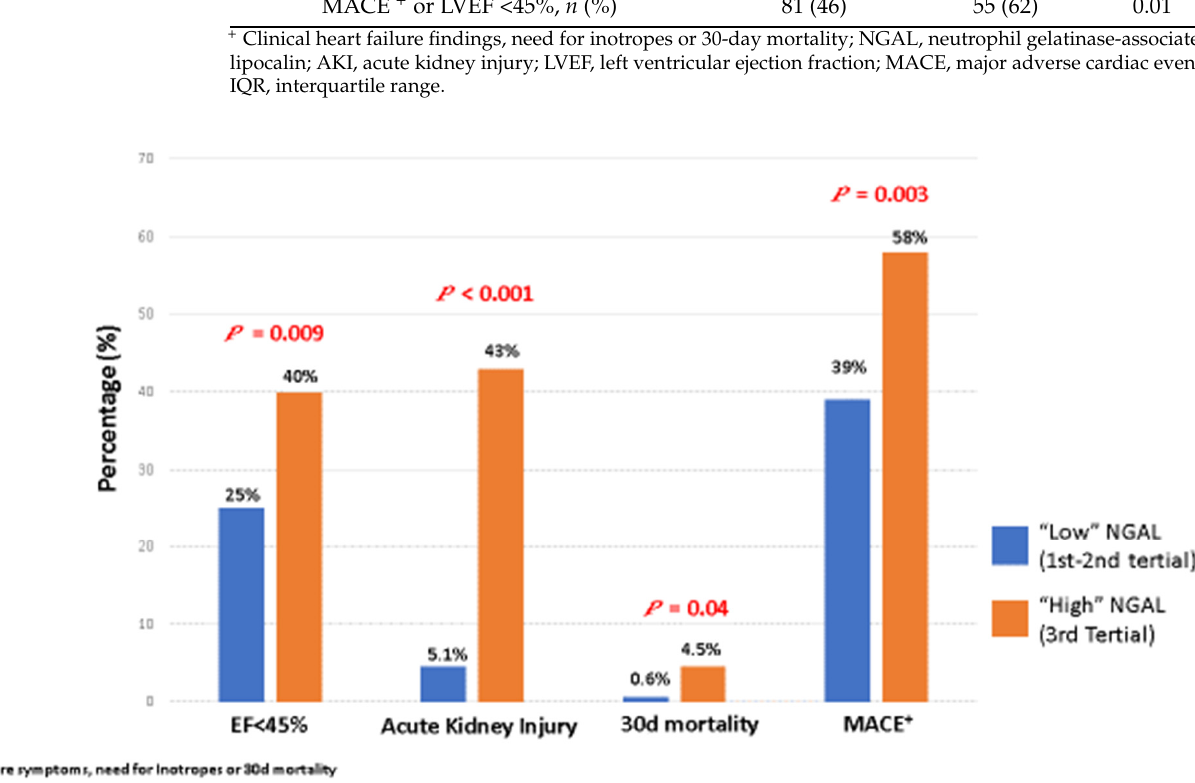
Figure 1. Adverse short-term clinical outcomes stratified by NGAL levels; + clinical heart failure findings, need for inotropes or 30-day mortality; NGAL, neutrophil gelatinase-associated Table 4. Multivariate binary logistic regression analysis for prediction of MACE +.